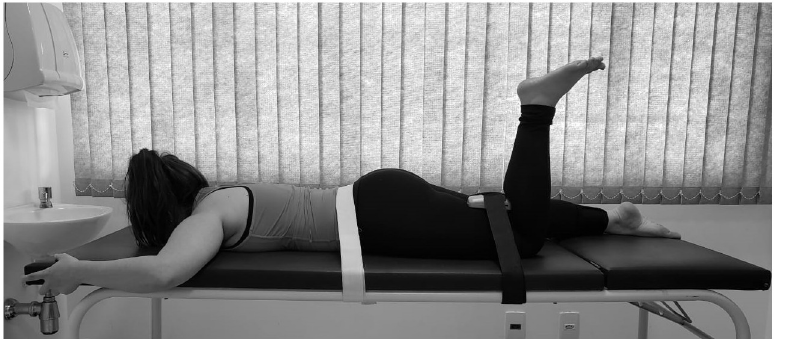
Fig 4. Hip extensor muscles